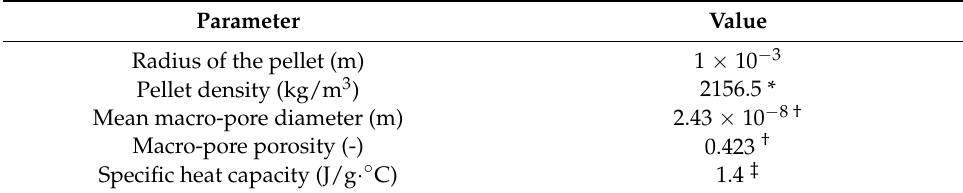
Table 9. Properties of COSMO zeolite 13X.